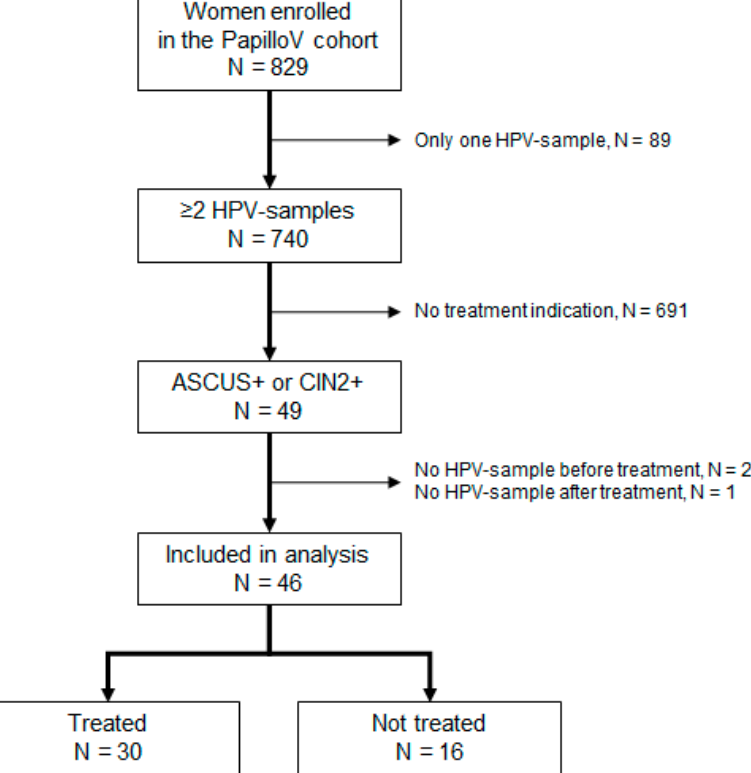
Figure 1. Flow chart of patient selection.